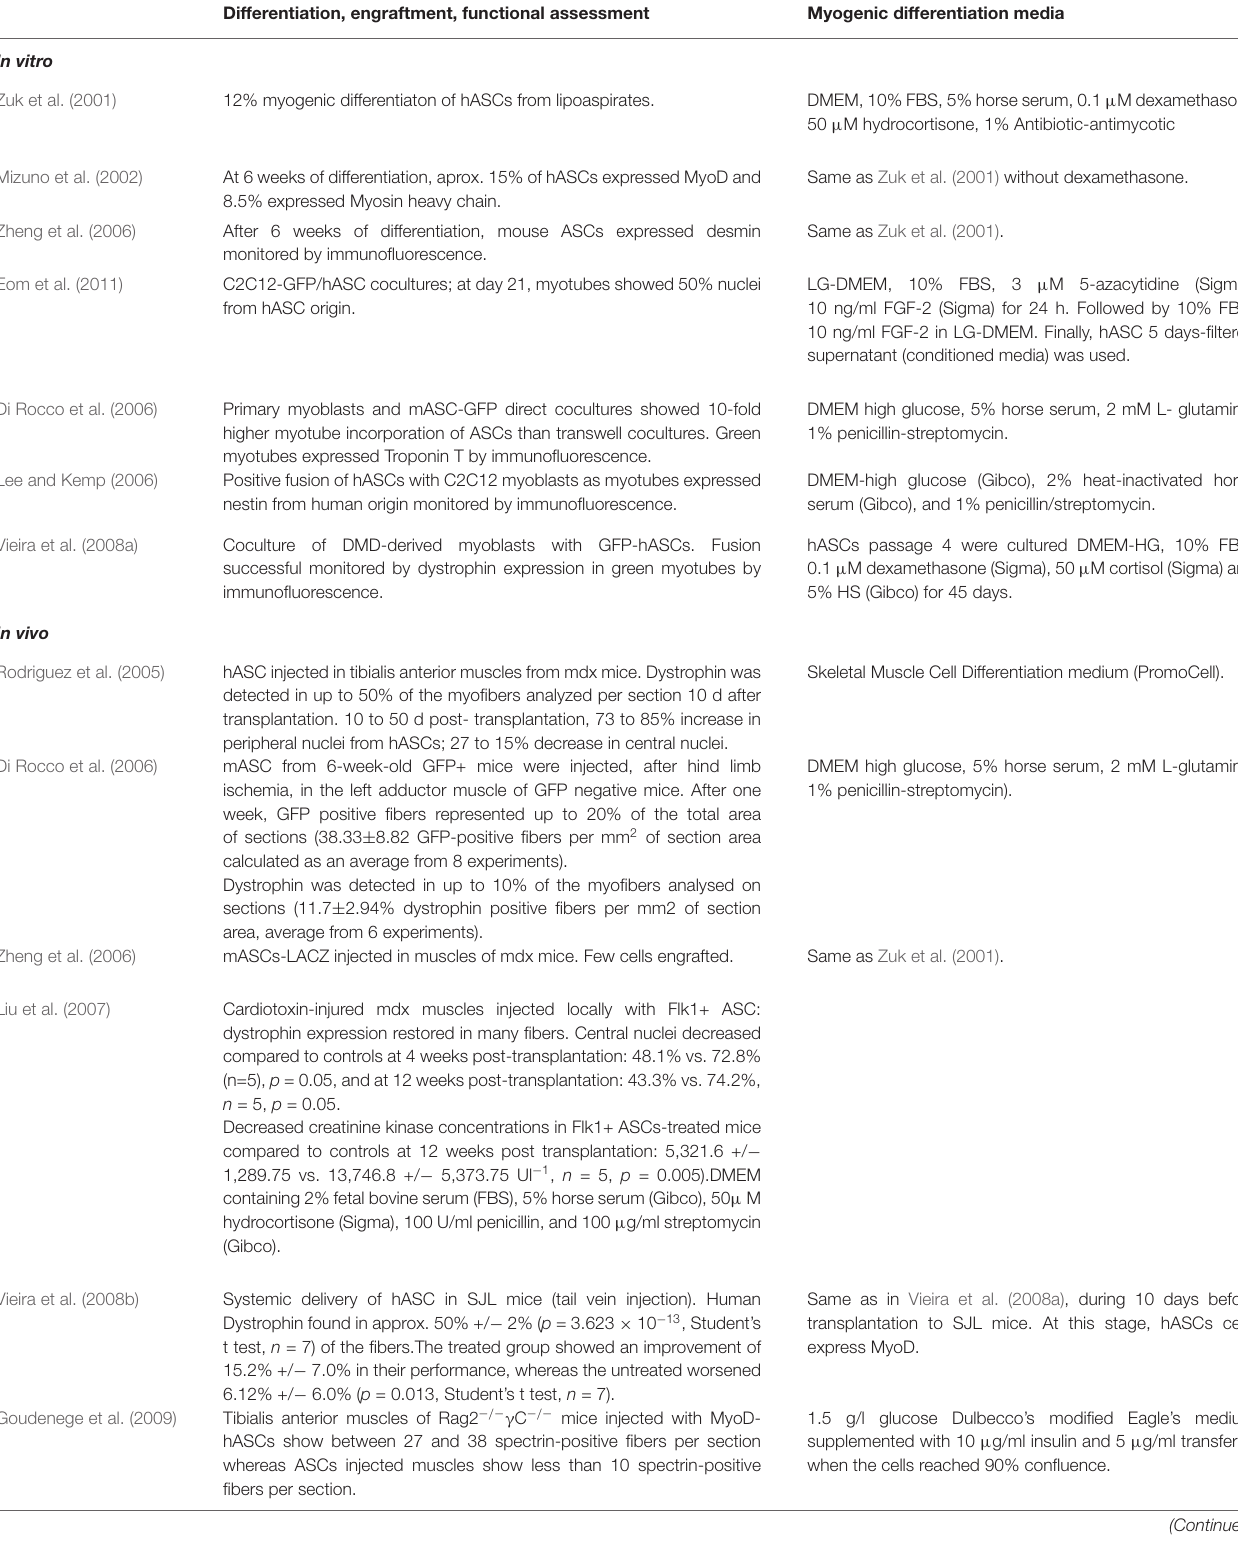
TABLE 1 | Summary of ASC’s myogenic differentiation, engraftment and functional assessment. Differentiation, engraftment, functional